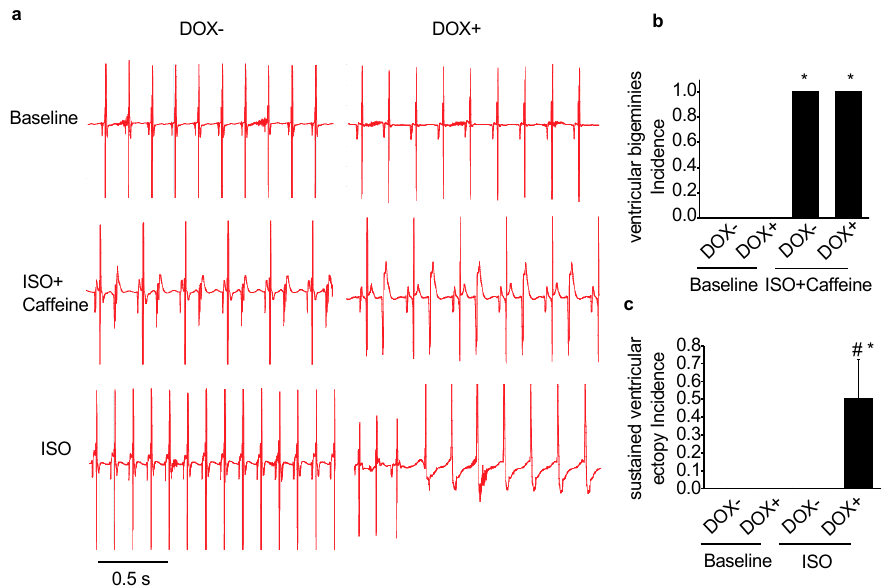
Figure 2. Acute SERCA2a overexpression exacerbated ventricular arrhythmias in a CPVT mouse model of CASQ2 KO. ( a ) representative ECG traces for the KO-TG mice before (DOX − ) and after the induction of SERCA2a overexpression (DOX + ); under baseline condition, or with injection of ISO or combination of ISO and ca ff eine; ( b ) the incidence of developing sustained ventricular ectopy in the presence of ISO and ca ff eine; ( c ) the incidence of developing ventricular bigeminy in the presence of ISO. * p < 0.05 vs. WT control; # p < 0.05 vs. DOX − .